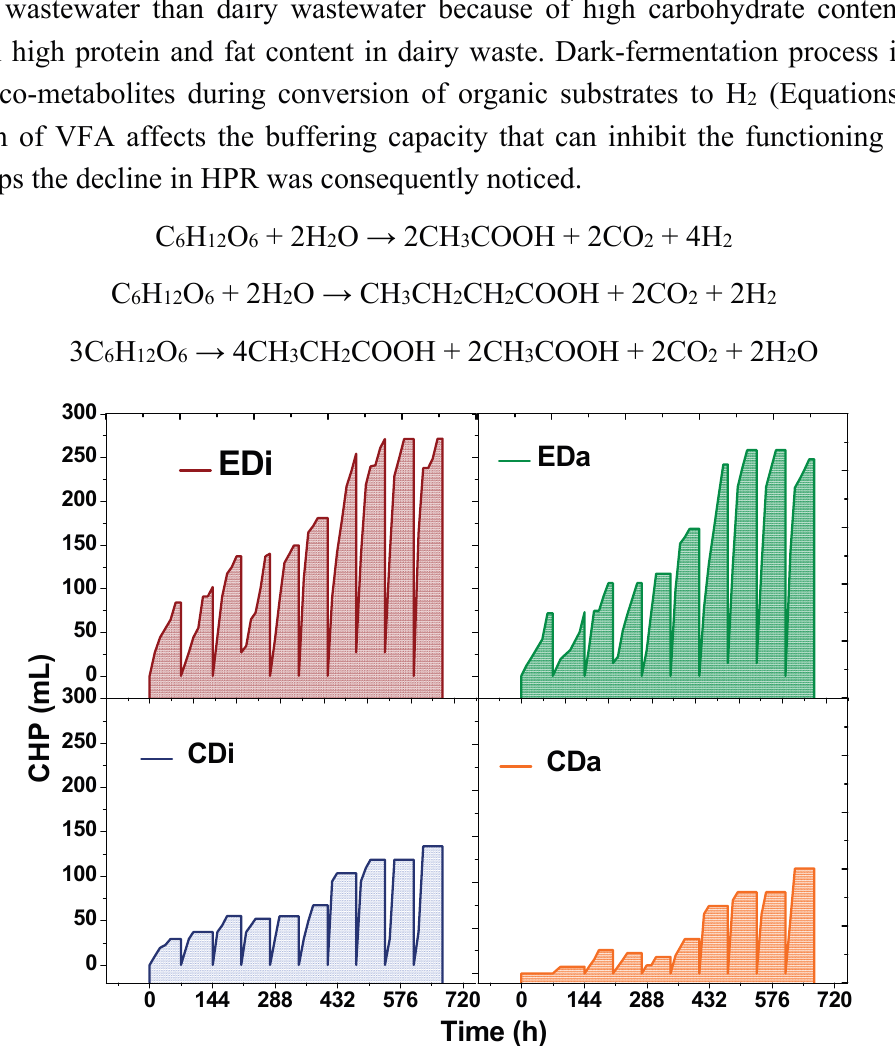
Figure 1. Temporal profile of Cumulative Hydrogen production (CHP) in dark-fermentative system (DFS-CDi, CDa) and augmented dark-photo fermentative system (ADPFS-EDi, EDa) as function of time with dairy and distillery